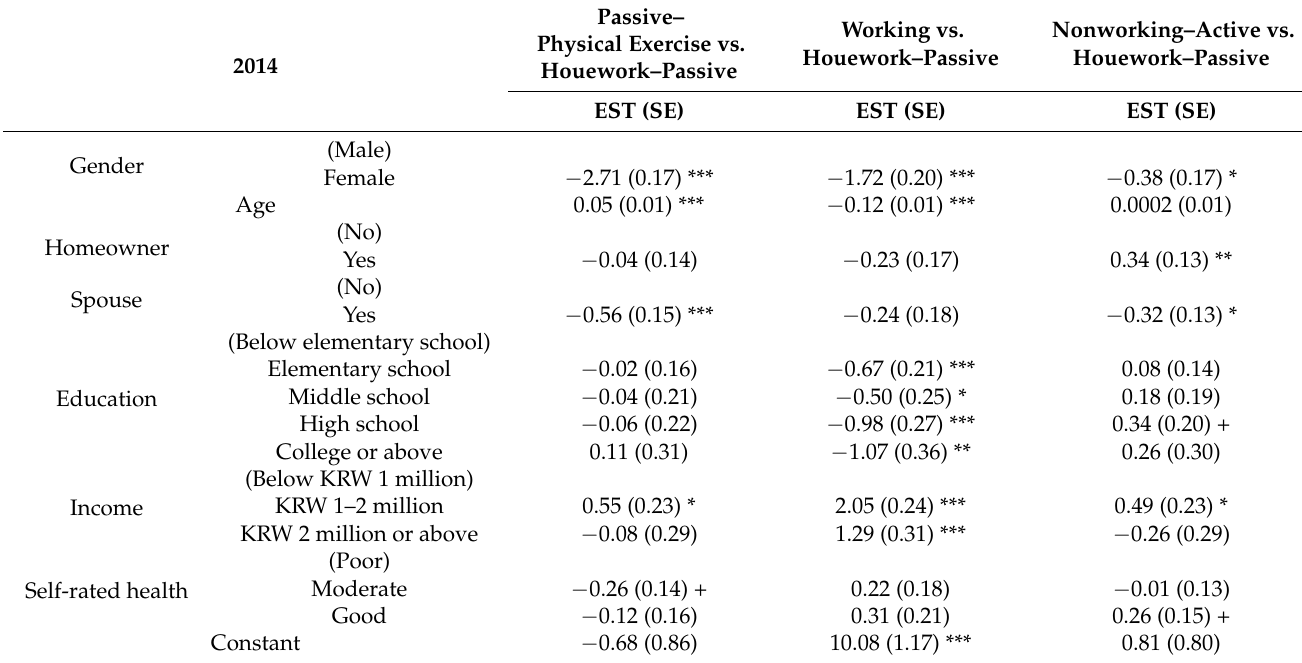
Table 7. Socioeconomic factors associated with activity groups (KTUS